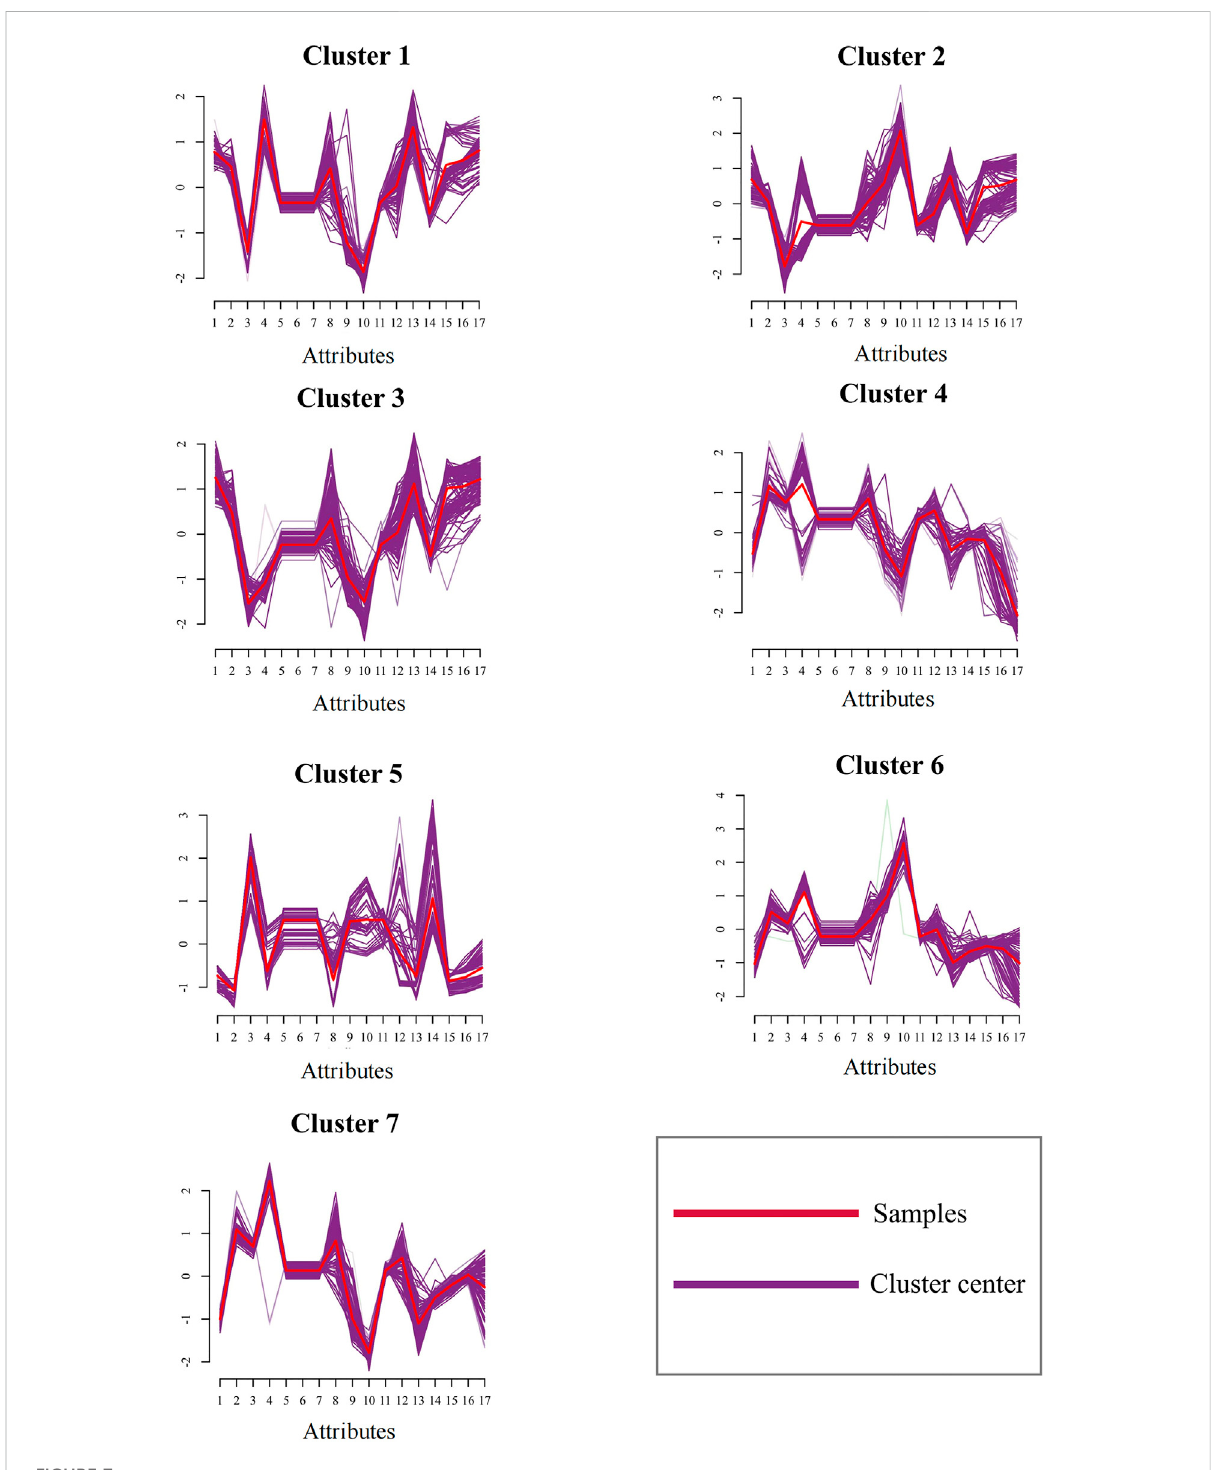
FIGURE 7 Clustering results by